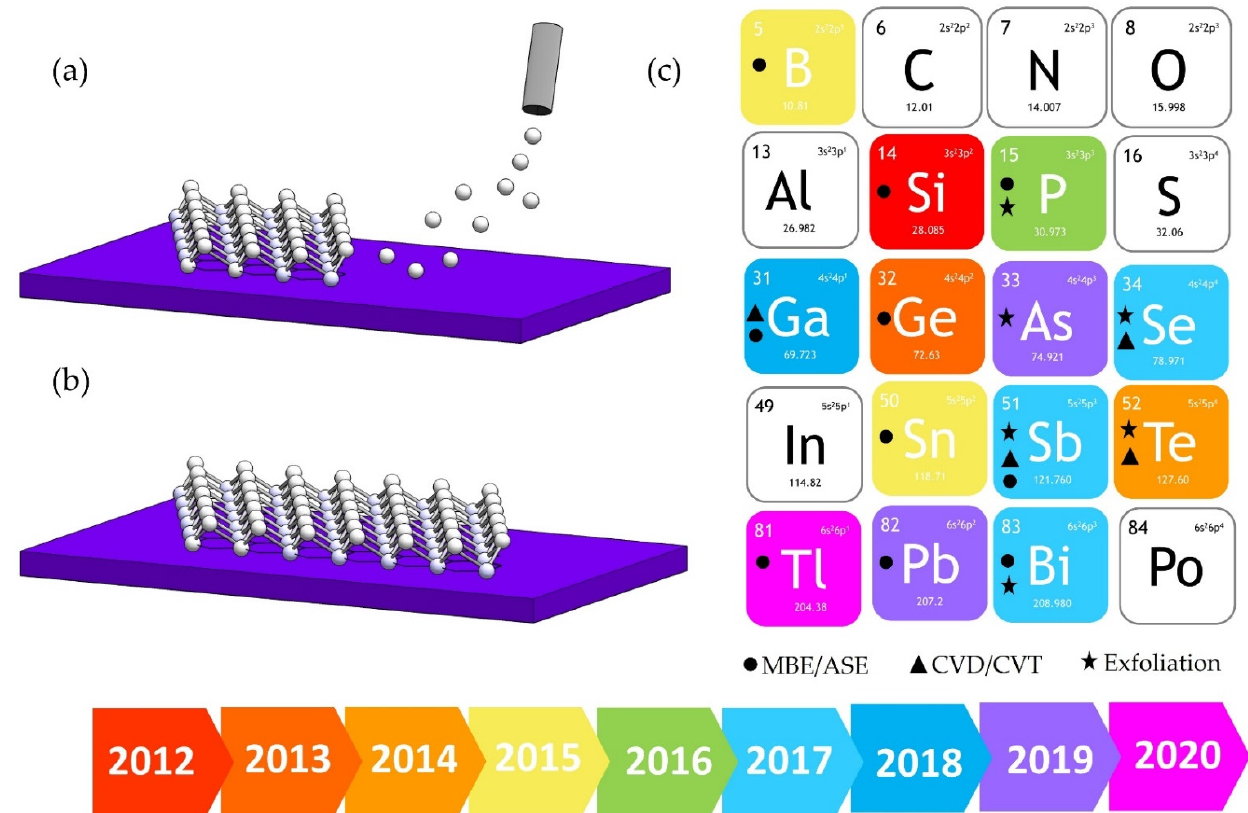
Figure 1. Schematics of the Xenes growth by epitaxy onto a commensurate substrate and Xenes periodic table. ( a ) The X element (white spheres) is typically evaporated on the supporting substrate whose symmetry imposes the buckled honeycomb structure to the incoming atoms provided that the substrate temperature is correctly set. ( b ) The buckled honeycomb lattice appears as a surface reconstruction of the underlying substrate. ( c ) The Xenes periodic table reporting the Xenes discovered so far (from 2012 to 2020) and the growth methods used for their synthesis. In column IIIA there are: borophene, gallenene and thallenene. All the elements below carbon in column IVA have a 2D counterpart. Phosphorene, arsenene, antimonene and bismuthene are the pnictogens Xenes (column VA). In column VIA selenene and tellurene are the chalcogens Xenes. The growth methods (MBE/ASE, CVD/CVT or exfoliation) for every Xene are also reported. It should be mentioned here that we do not have the intention to provide a complete list as the field is evolving rapidly. At the bottom, the timeline evolution of the Xenes discoveries from 2012 to 2020.